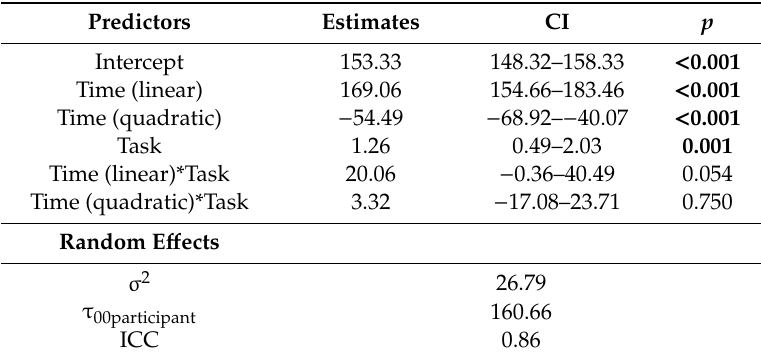
Table A2. Estimates and significance values for fixed-effects in the HR model.